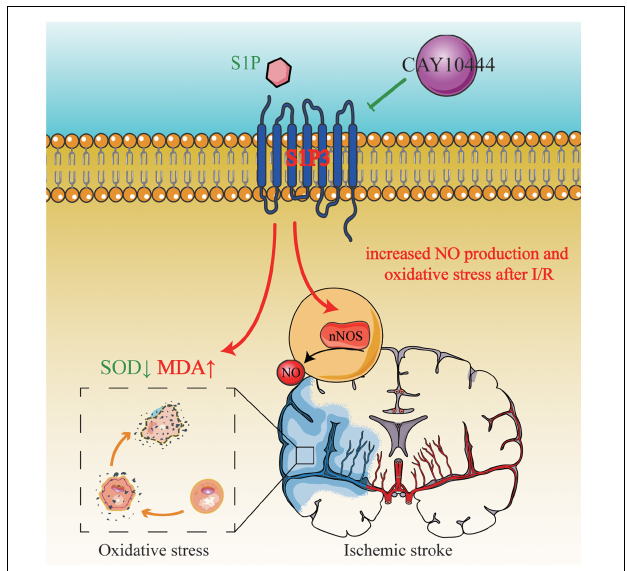
FIGURE 7 | S1PR3 mediates nNOS/NO and oxidative stress during cerebral ischemia and